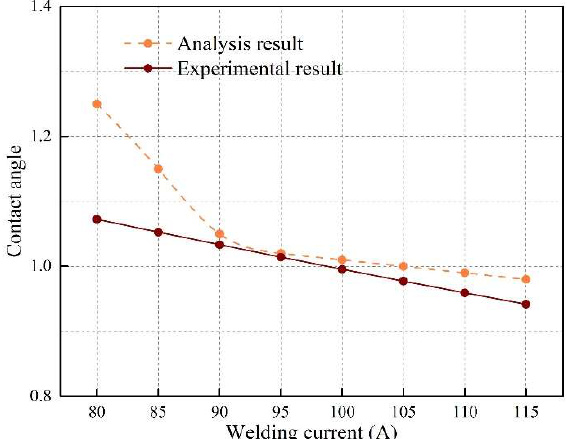
Figure 17. The change trend of the spreading contact angle of the molten pool.